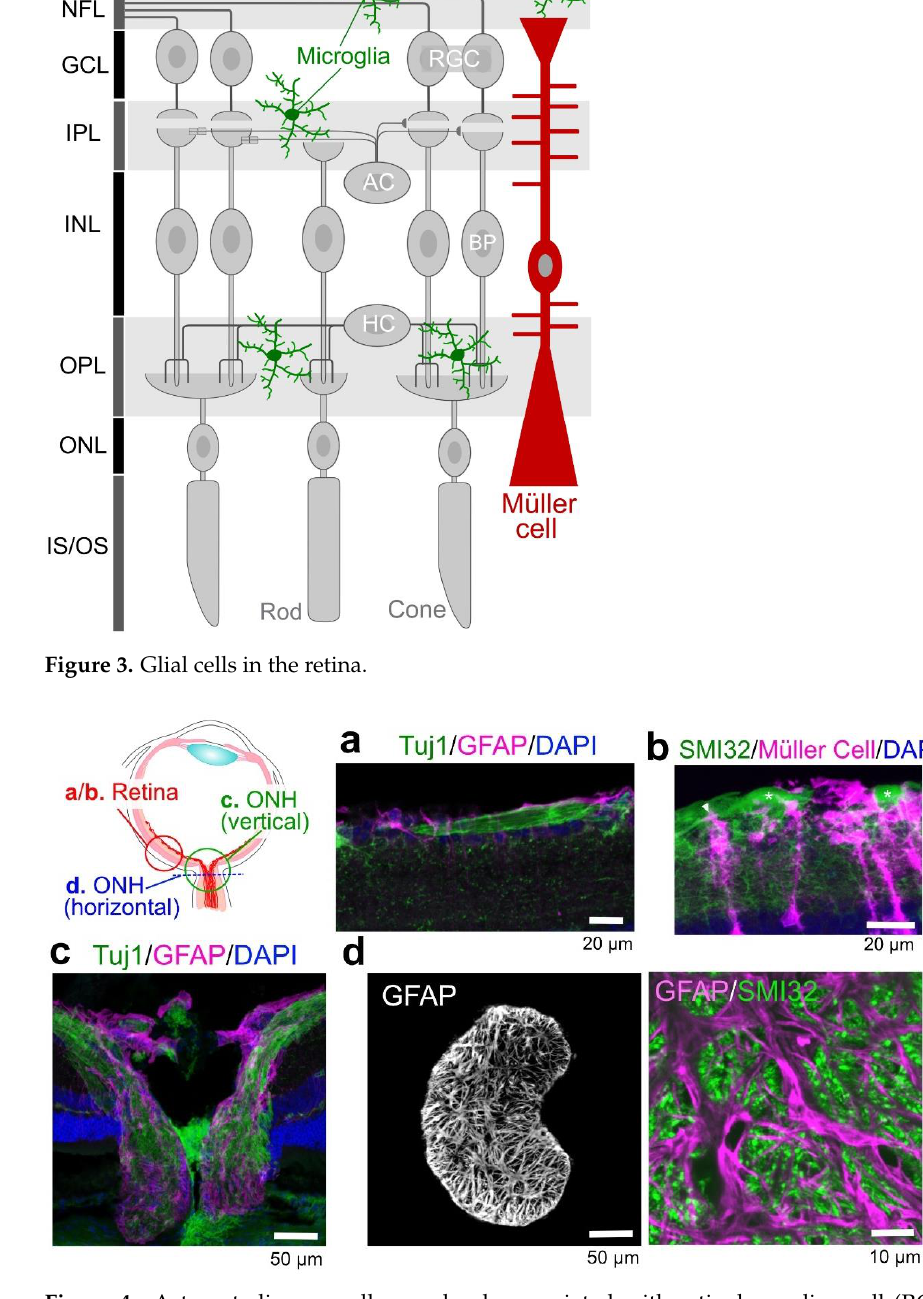
Figure 4. Astrocyte-lineage cells are closely associated with retinal ganglion cell (RGC) axons. ( a ) Retinal astrocytes (magenta) attach to Tuj1-positive RGC axons (green). ( b ) YC-Nano-expressing Müller cells [36] (magenta) elongate their processes toward and surround RGC soma (green, asterisk). A part of the Müller cell processes enwraps SMI32-positive RGC axons (arrow). ( c ) Vertical section of the optical nerve head (ONH). GFAP-positive astrocytes are highly enriched and closely attached to the optic nerve. ( d ) Horizontal section of the ONH: ( left ) an astrocyte forms a honeycomb structure and ( right ) RGC axons pass through the